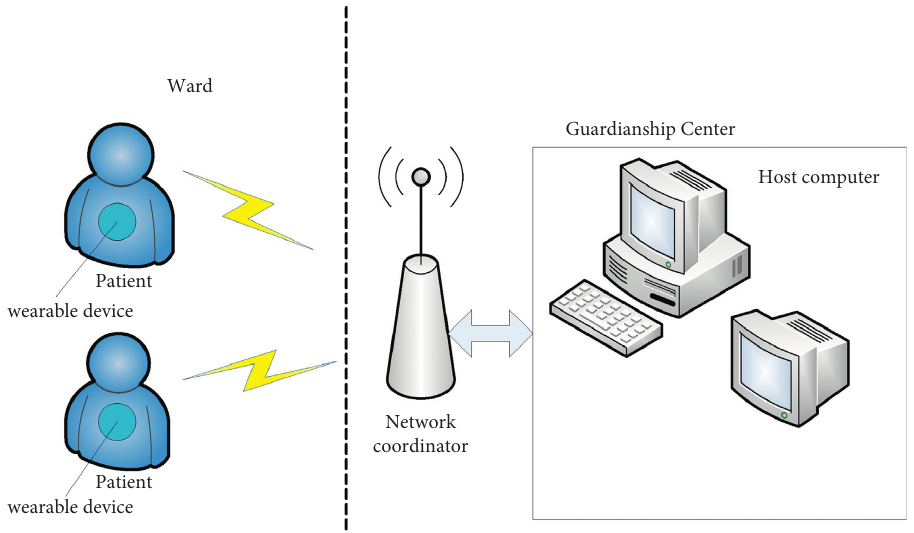
Figure 1: The physiological feature monitoring system architecture diagram based on